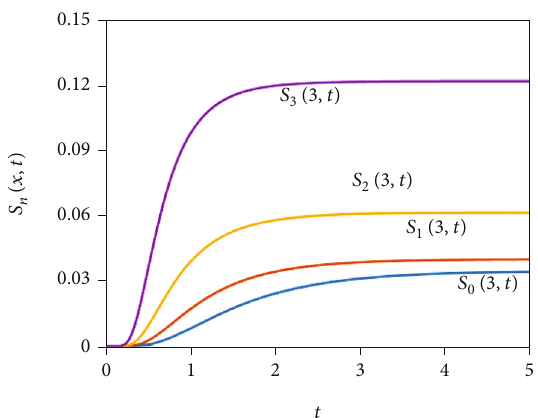
x , t Þ against real endpoint t > 0 for various values of Figure 1: S n ð integer order n at x = 3 .